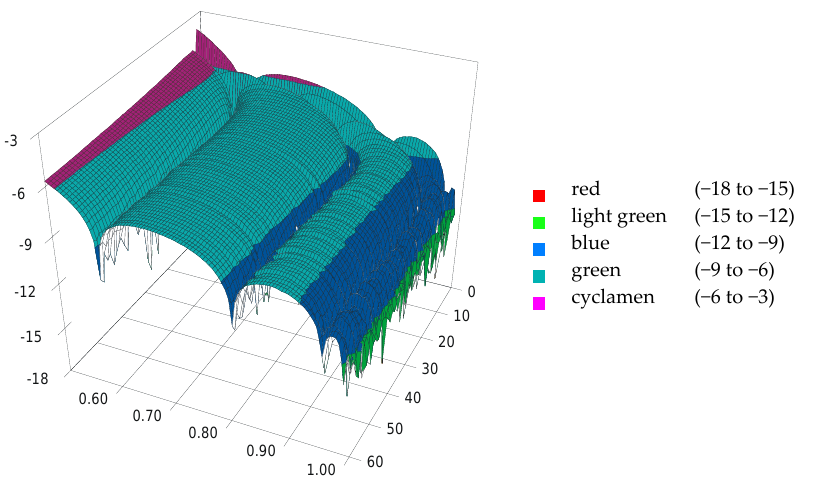
Figure 4. 3D plot of the estimation error for data expressed in logarithm scale as function of p (ranging from 0.500 to 0.999) and n (ranging from 2 to 61).